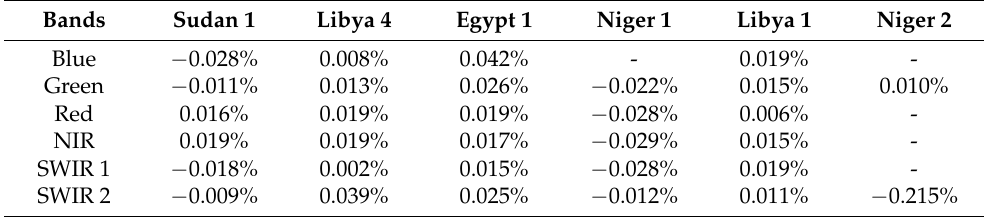
Table 15. Summary of long-term TOA reflectance change per year (in %) for all PICS. Bands Sudan 1 Libya 4 Egypt